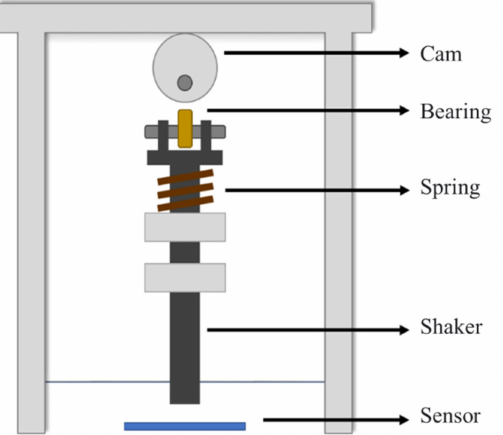
Figure 9. Self-made miniaturized dynamic force platform for analyzing the effects of environmental temperature on the tactile sensing